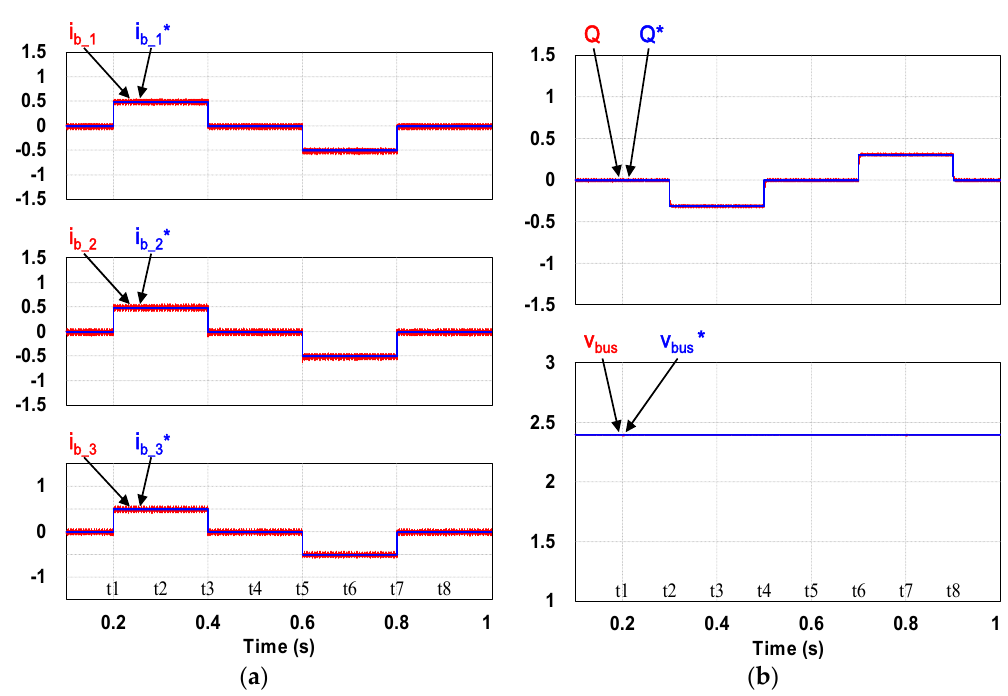
Figure 27. Waveforms of control commands and feedbacks: ( a ) three interleaved inductor currents; ( b ) reactive power (top), DC bus voltage (bottom).